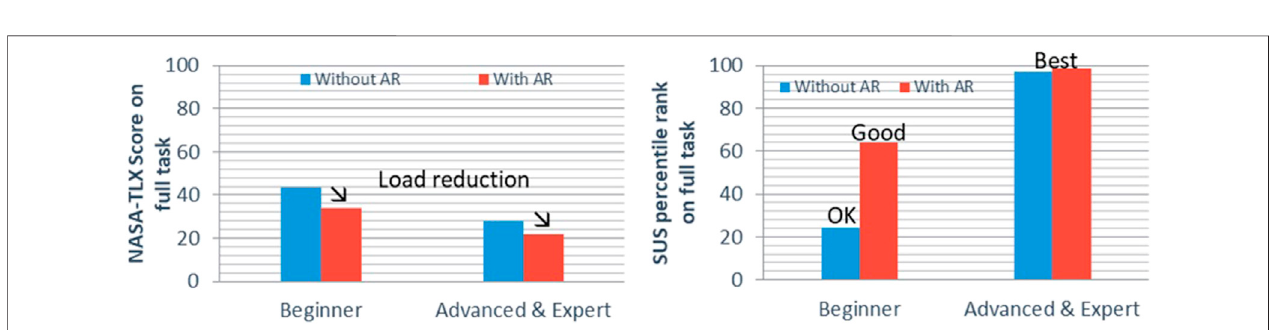
Frontiers in Virtual Reality |